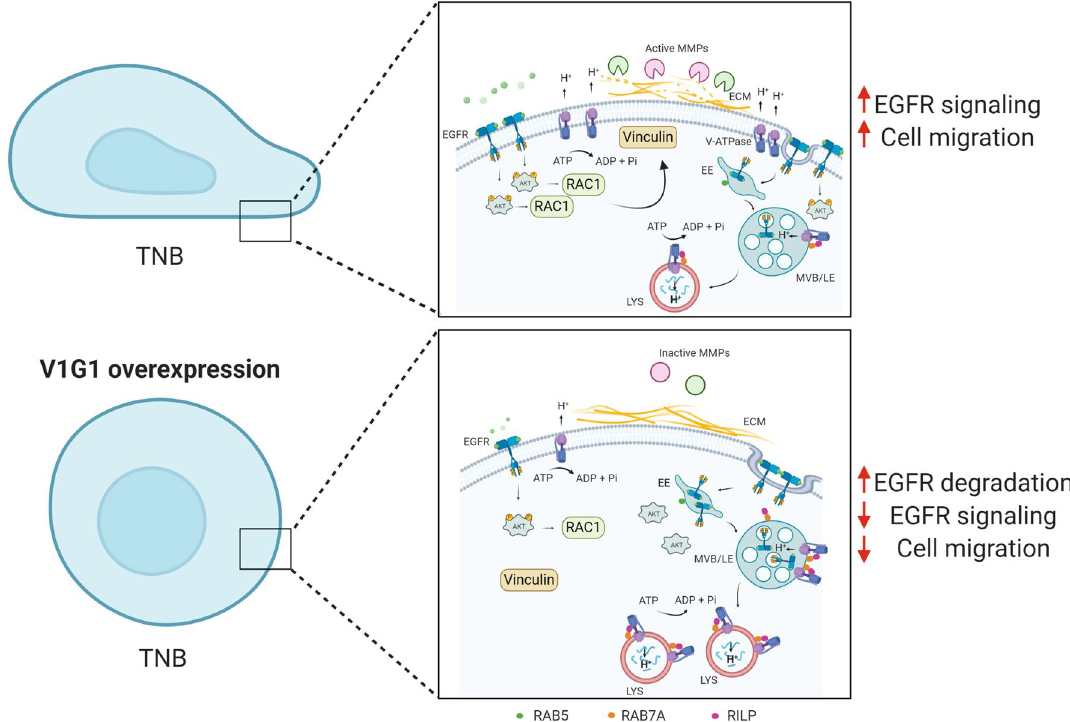
Figure 7. Proposed molecular model. In TNB breast cancer cell lines, overexpression of V1G1 affects cell migration in vitro by modulating EGFR stability and signaling that control activation of RAC1 and vinculin assembly. Similarly, overexpression of RAB7 affects EGFR degradation but also positioning of V-ATPase on endocytic organelles through RILP. In addition, overexpression of V1G1 reduces activation of MMPs that degrade extracellular matrix favoring cell migration in vivo. ECM extra-cellular matrix, EE early endosome, MVB multivesicular bodies, LE late endosome, LYS lysosome. Created with